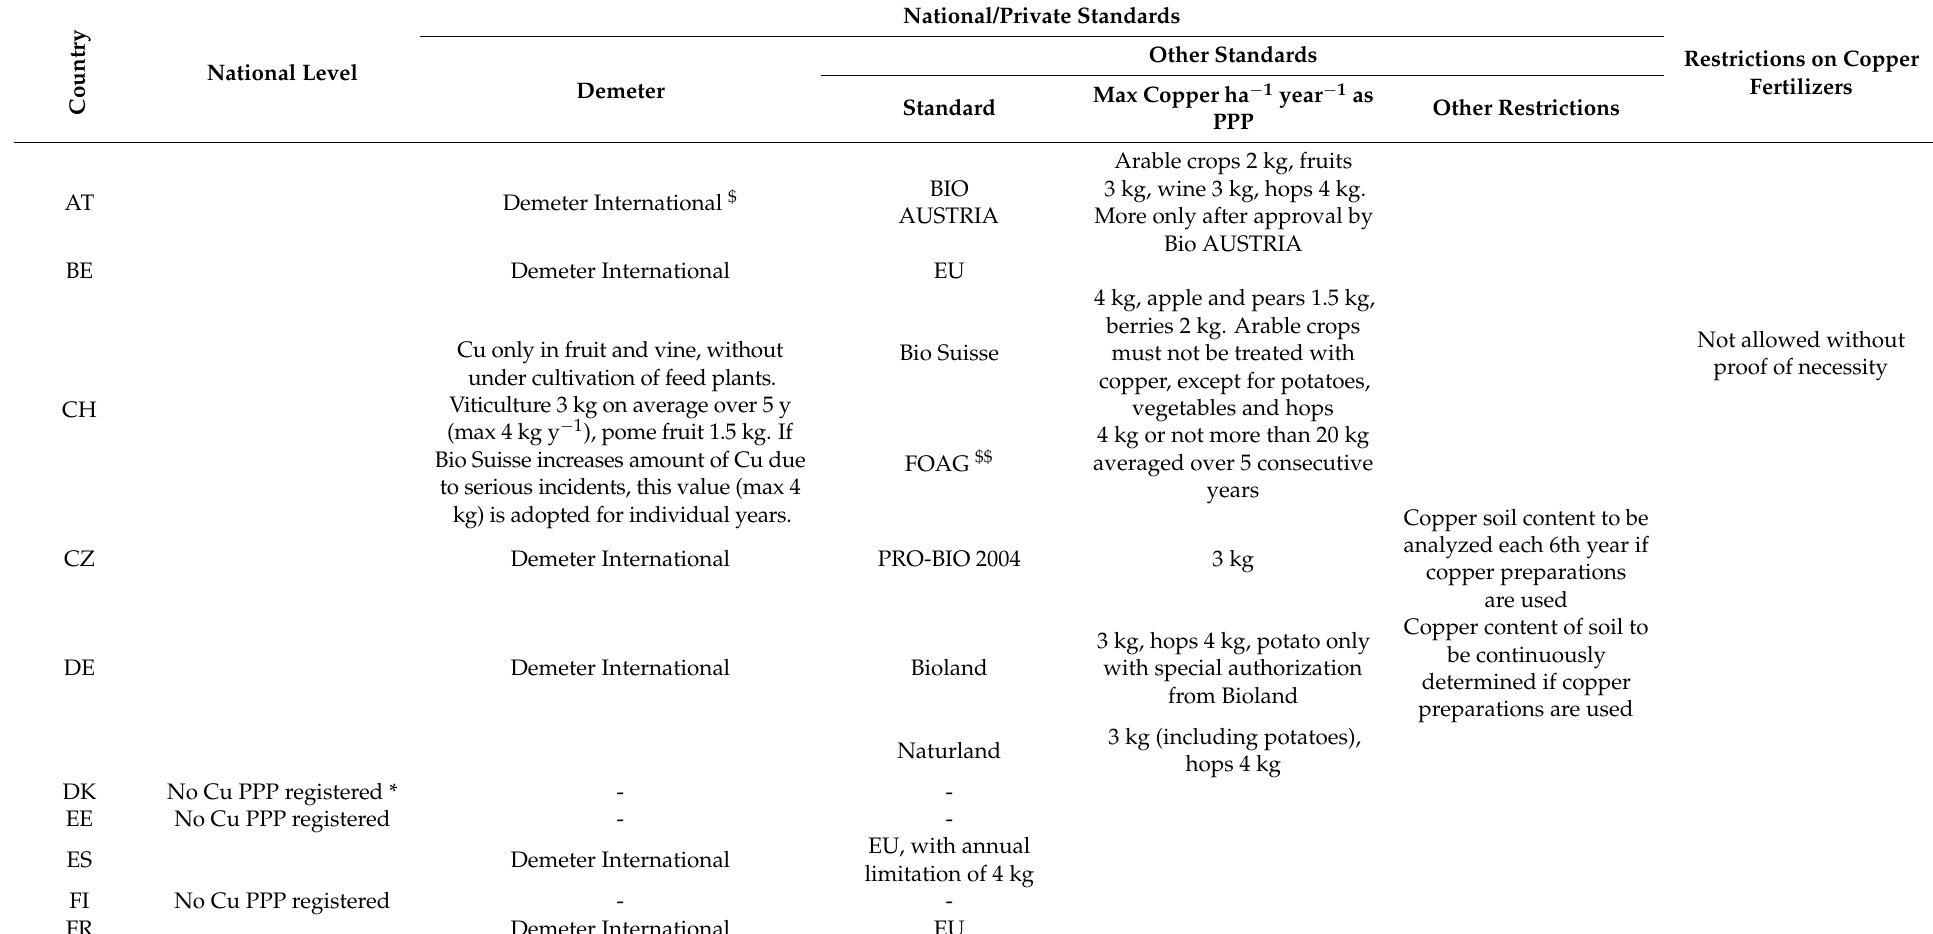
Table 2. Restrictions of copper use in the private sector by farmers’ associations in 19 selected European